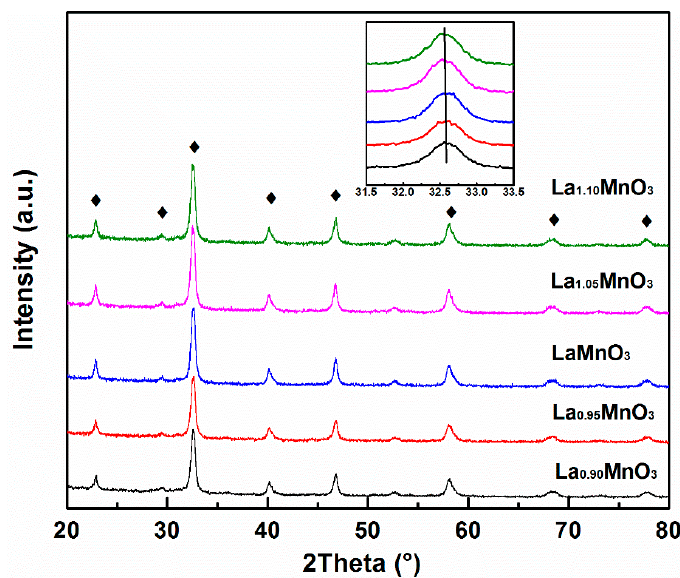
Figure 1. XRD patterns of La x MnO 3 catalysts.